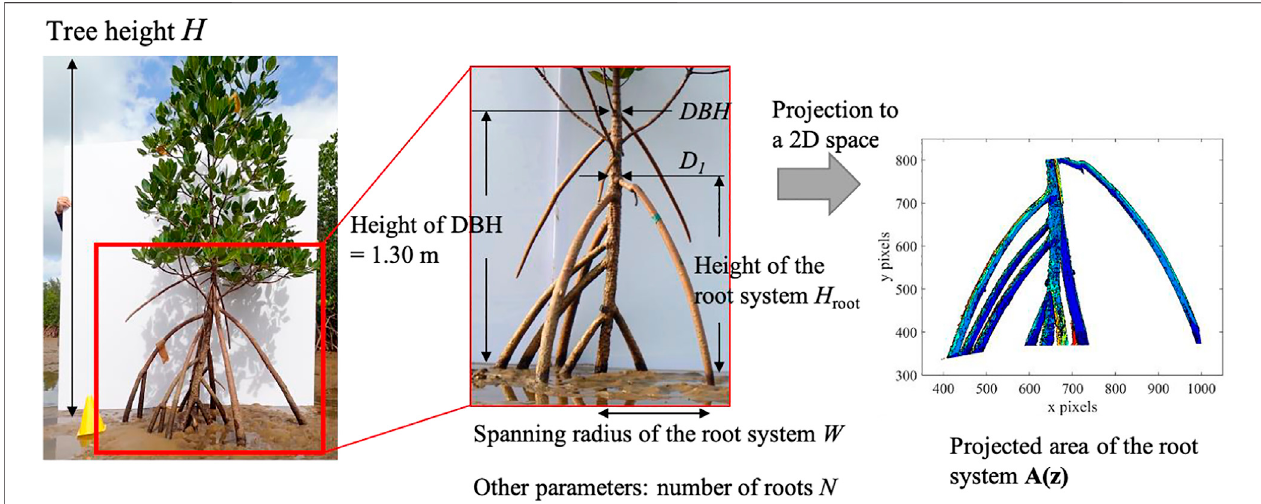
FIGURE 1 | Characteristic mangrove root morphology and the measured parameters in fi elds (red boxed area in the photo corresponds to the root system).